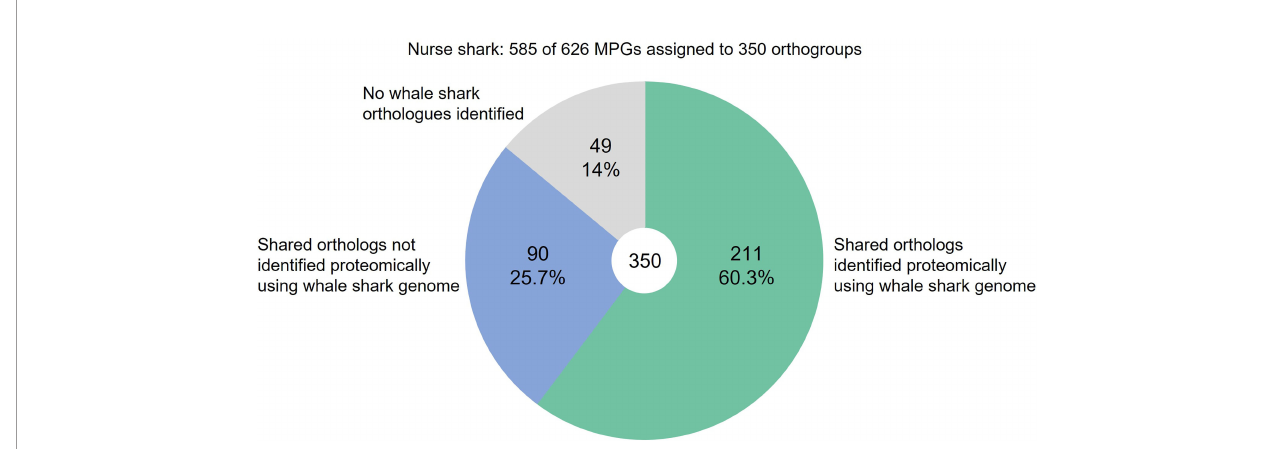
FIGURE 5 | Proportion of nurse shark plasma proteins detected when using the whale shark genome as the reference database compared with the species- matched